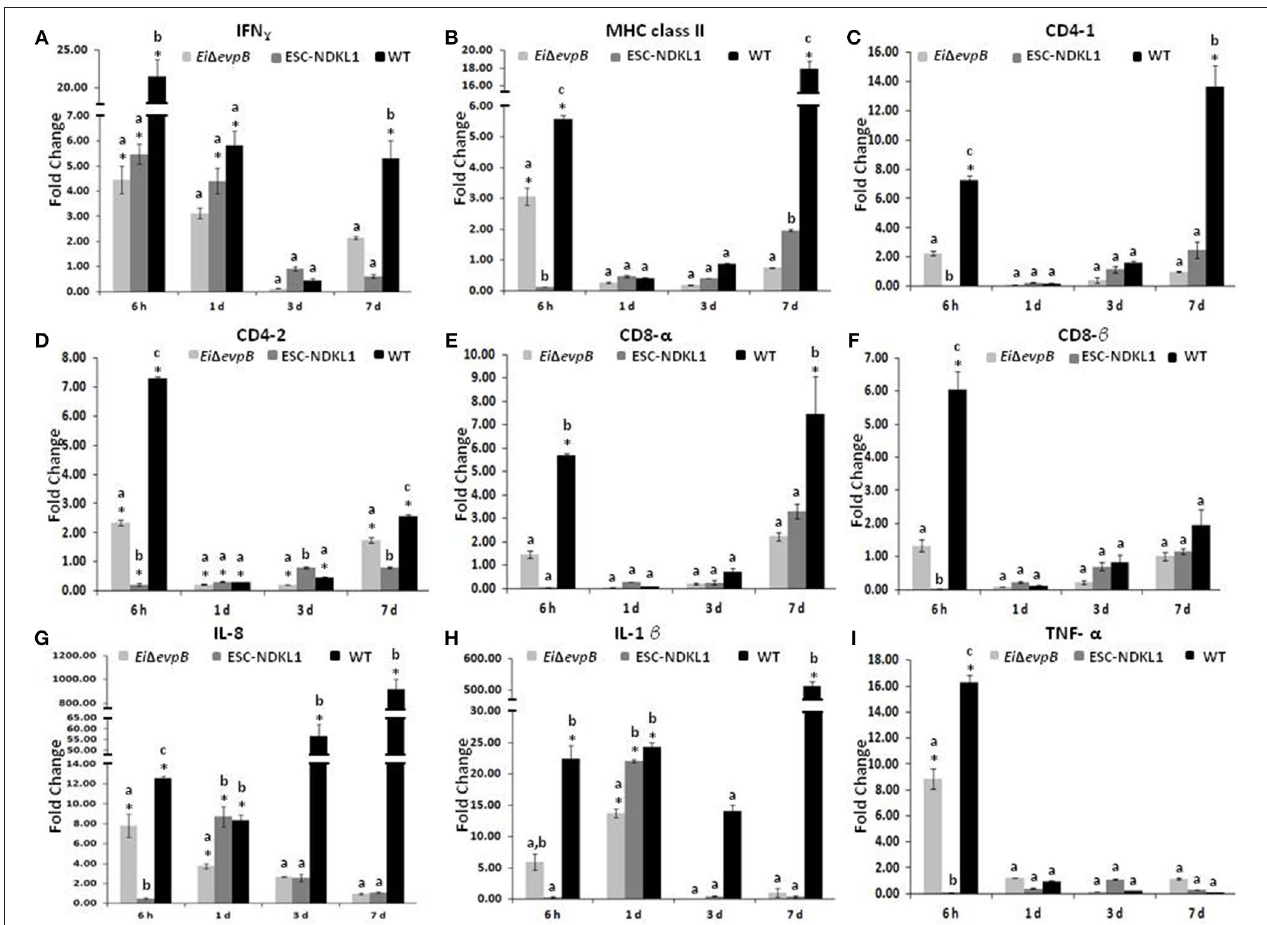
FIGURE 2 | Changes in the expression of IFN- γ (A) , MHC class II (B) , CD4-1 (C) , CD4-2 (D) , CD8- α (E) , CD8- β (F) , IL-8 (G) , IL-1 β (H) , and TNF- α (I) genes in the anterior kidney of catfish challenged with E. ictaluri LAV and WT strains. Data are presented as fold difference of gene expression compared with values obtained for control uninfected cells. Samples were analyzed in triplicates from a pull of AK of six fish and presented as mean ± SD. P < 0.05. *Indicates significant differences compared to uninfected control ( p < 0.05). abc Indicates differences within each time point ( P < 0.05).